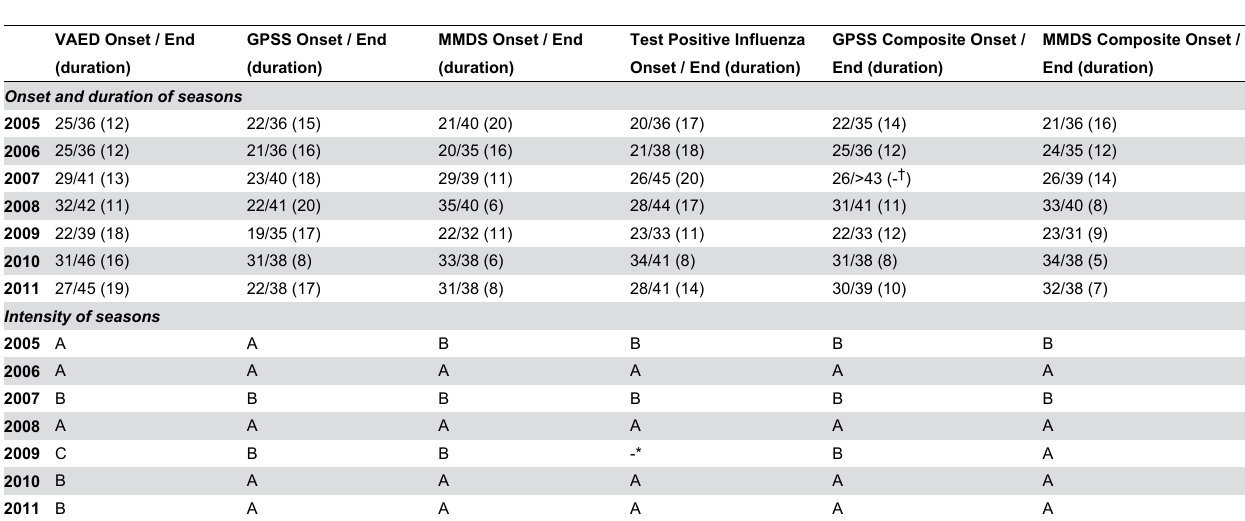
Table 2. Onset, duration and intensity of influenza season, by year and surveillance dataset, Victoria, 2005 to 2011.